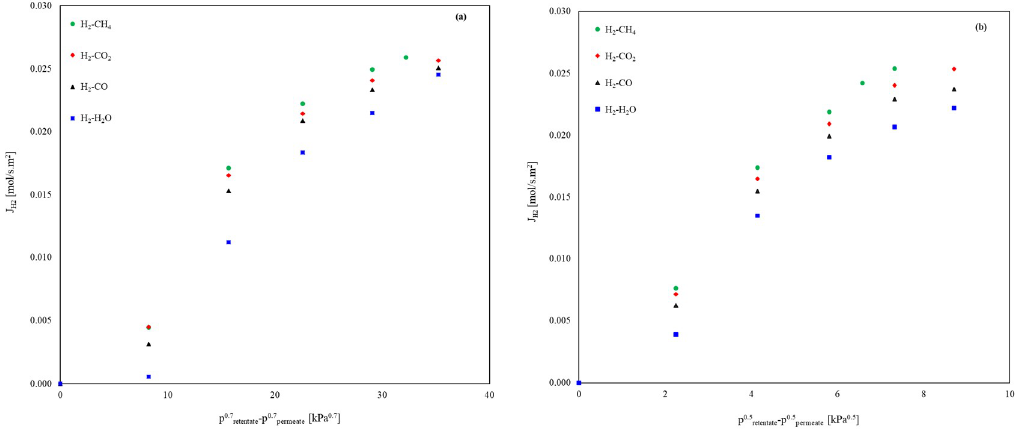
Figure 7. Influence of impurities on the permeation flux of H 2 in ( a ) Pd/YSZ and ( b ) Pd-Au/Al 2 O 3 membranes.